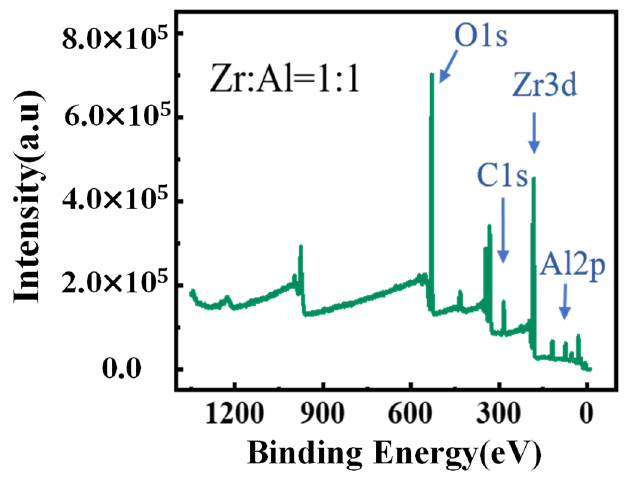
Figure 6. XPS spectra of overview scans for the ZAO (Zr:Al = 1:1) film.